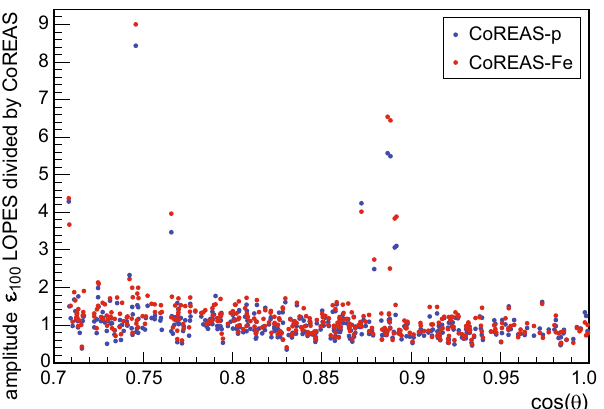
Fig. 12 Ratio of the measured amplitude (cid:4) 100 at 100m axis distance and the simulated amplitude of the CoREAS end-to-end simulations including noise for 380 events passing all quality cuts (left). In the pro-